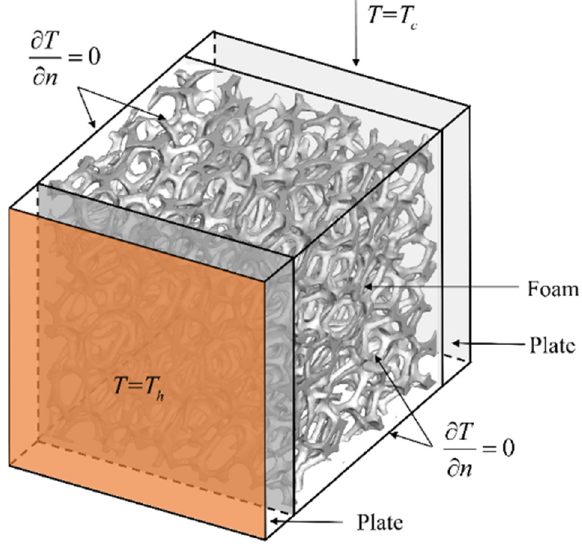
Figure 5. The diagrammatic of the computational model.